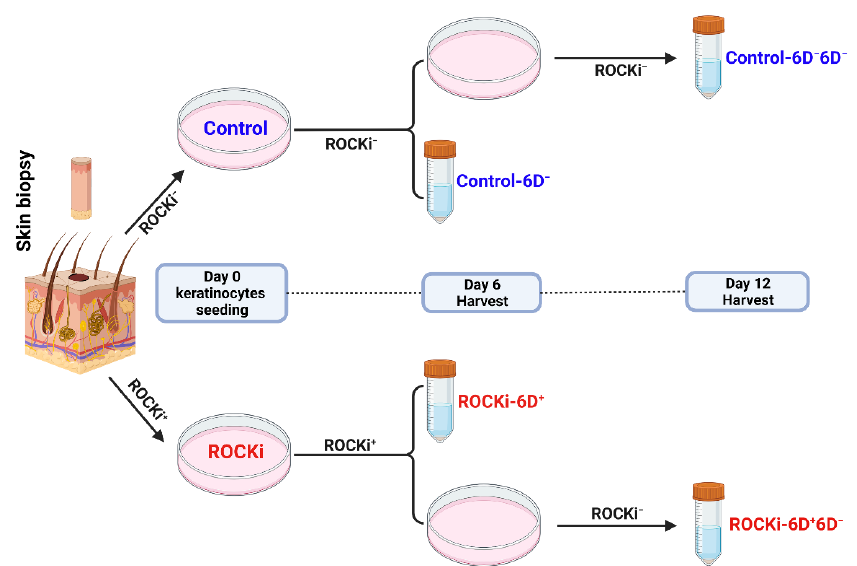
Figure 1. Workflow of experiments and sample collections. Freshly isolated keratinocytes (passage 0) were divided into two populations, either with ROCKi (10 µ M Y-27632) or without ROCKi treatment (0.1% DMSO) for six days. Half of the cells were harvested on day 6 and the remaining cells were passaged and cultured without ROCKi for additional six days and then harvested. Image created with BioRender.com.